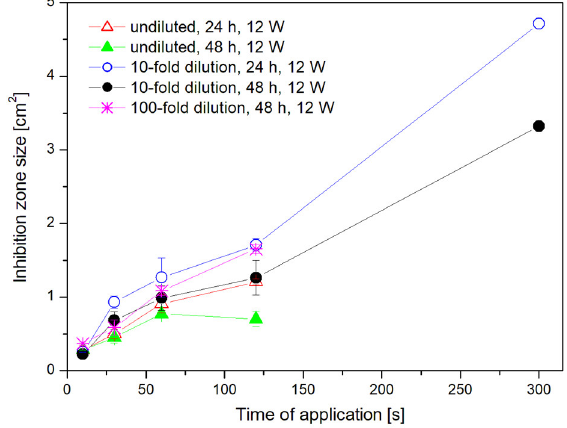
Figure 11. Dependence of the inhibition zone size on the exposure time using power of 12 W.